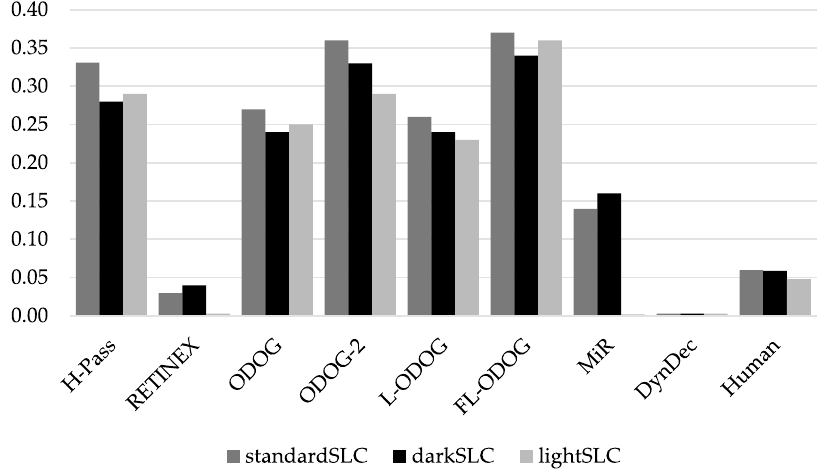
Figure 6. Difference in lightness between left and right target by models and human participants for three target luminance variations of SLC. Values for RETINEX, MIR and DynamicDecorrelation are barely visible because they are at zero.